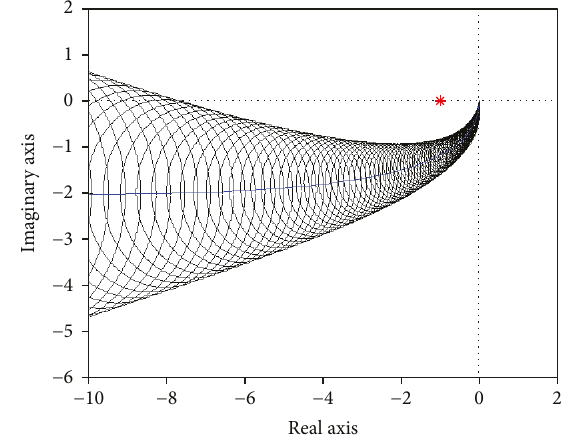
Figure 15: Bode magnitude plots — set of FO normalized perturbations and weight function (34).